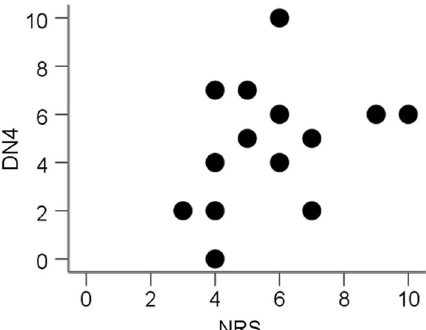
Fig. 1 Scatter plot showing no correlation between DN4 and NRS scales for 14 patients (Spearman’s Kendall’s rho 0.357, p